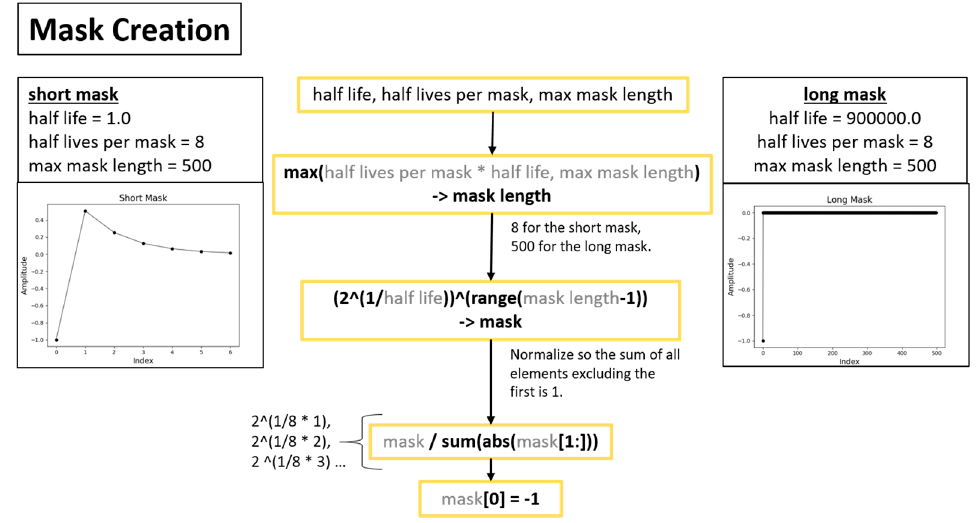
Figure 6. Overview of mask creation for implementing the complexity-pursuit solution to the blind source separation problem.